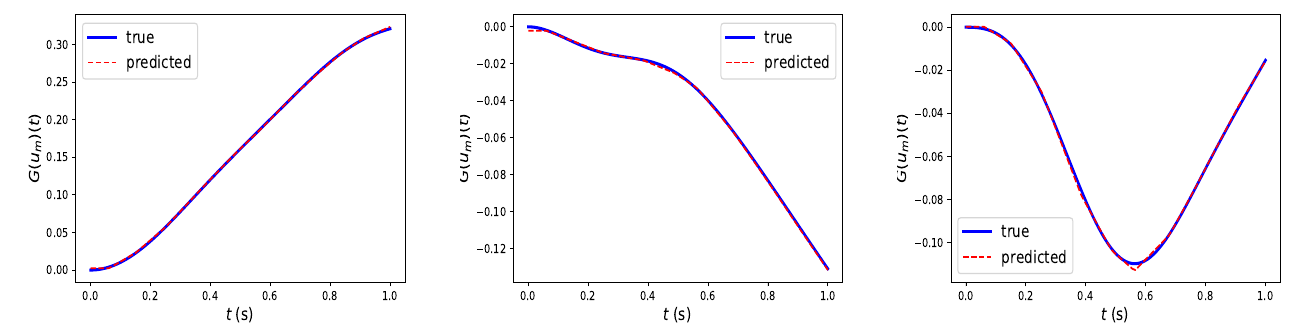
Figure 3. Fed-DeepONet G θ ∗ prediction of three solution trajectories driven by three inputs generated using a Gaussian Random Field but not included in the training dataset. The computed L 2 -relative = 0.442%, ( middle ) e = 1.252%, and ( right ) e = 1.561%. errors are: ( left ) e L L 2 L 2 2